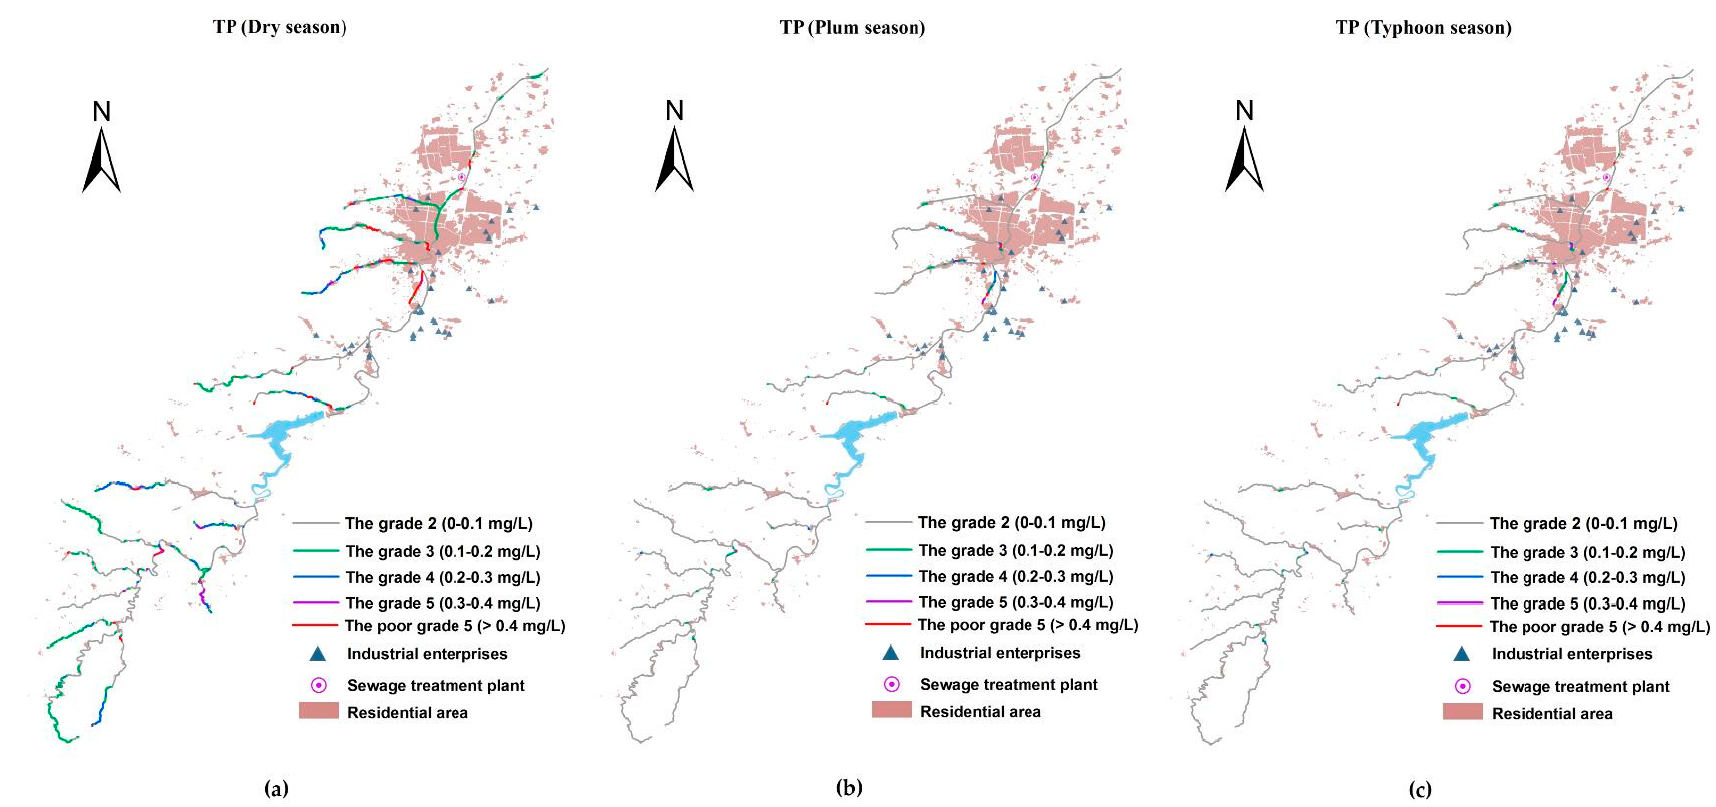
Figure 9. The space–time distribution of TP water quality standard for the Xian-Jiang Basin: ( a ) concentrations in the dry season; ( b ) concentrations in the plum rain season; and ( c ) concentrations in the typhoon season.